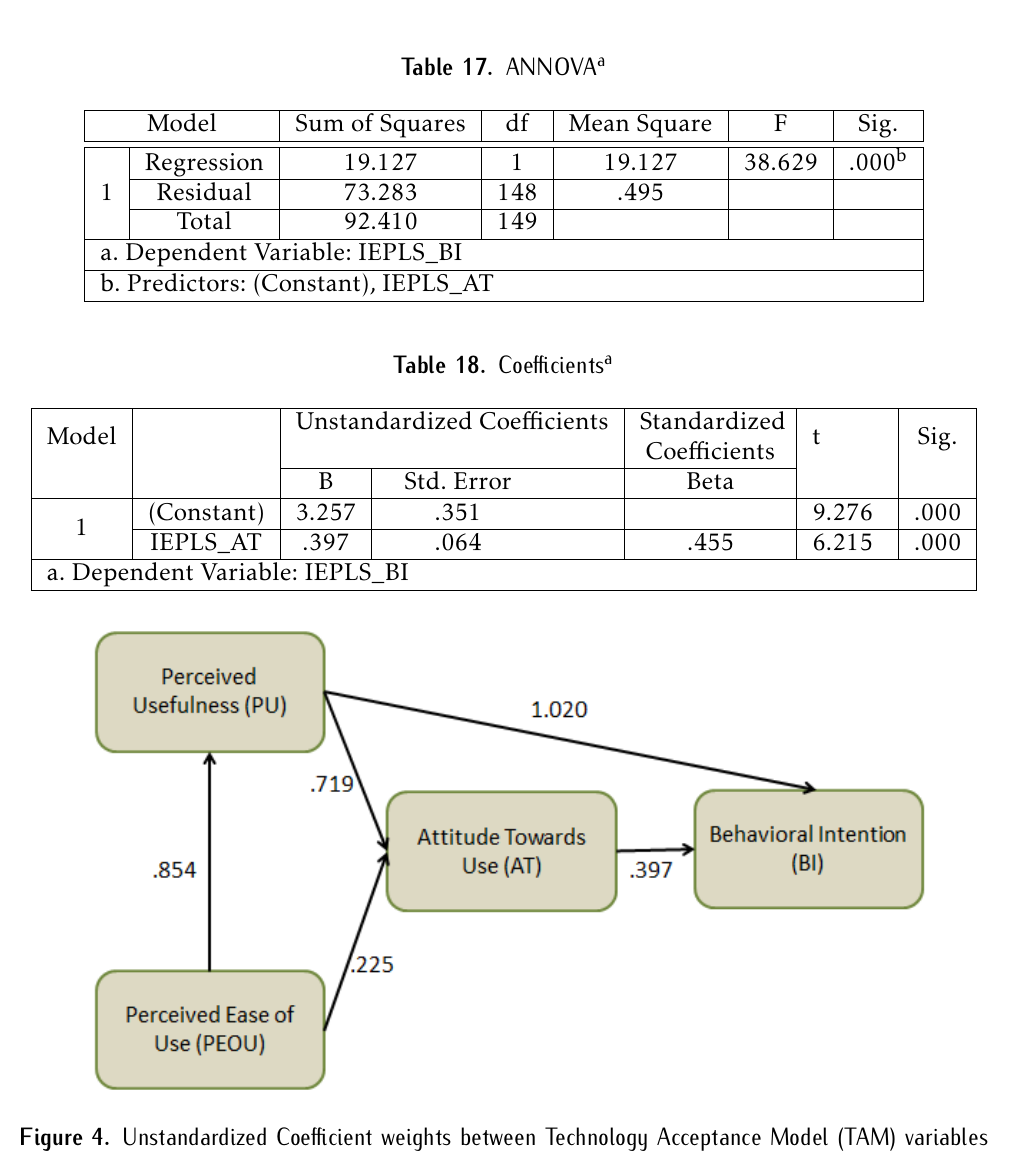
Figure 4. Unstandardized Coefficient weights between Technology Acceptance Model (TAM)